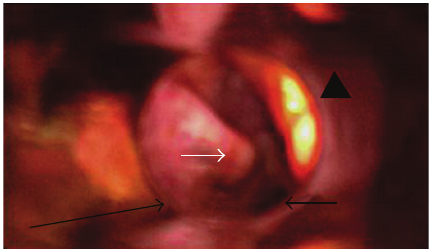
Figure 1: EUA. Direct hypopharyngoscopy, white arrow shows the bulge of the posterior hypopharyngeal wall into left piriform sinus. The long black arrow shows the posterior pharyngeal wall while the head of an arrow demonstrates the epiglottis. The short black arrow shows small part of the glottis marginally visible through the direct endoscope.